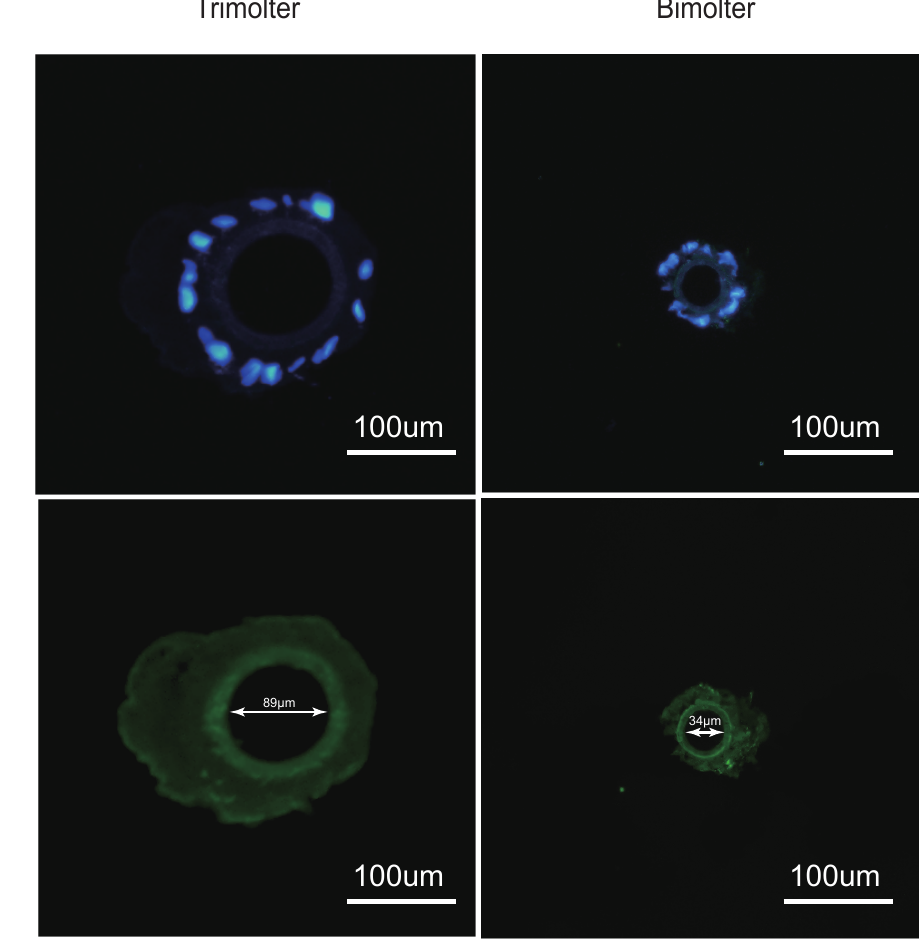
Figure 5. Chitin-stained of anterior silk gland from bimolter treatment groups and trimolter control groups. Slides were stained with wheat germ agglutinin (WGA) (green), whereas the nucleus was stained with DAPI (blue). The innermost green ring is the silk gland endometrium consisted of the chitin